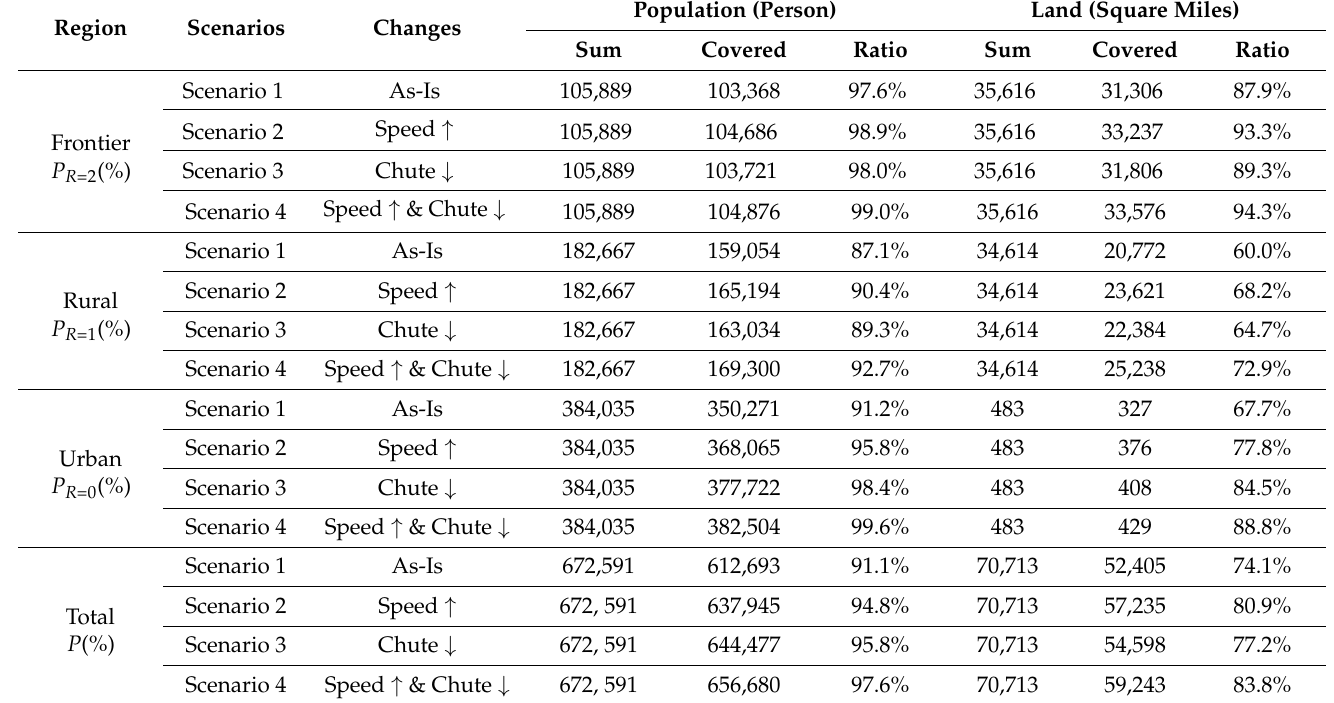
Table 4. Population and land coverage by each scenario for each geographic